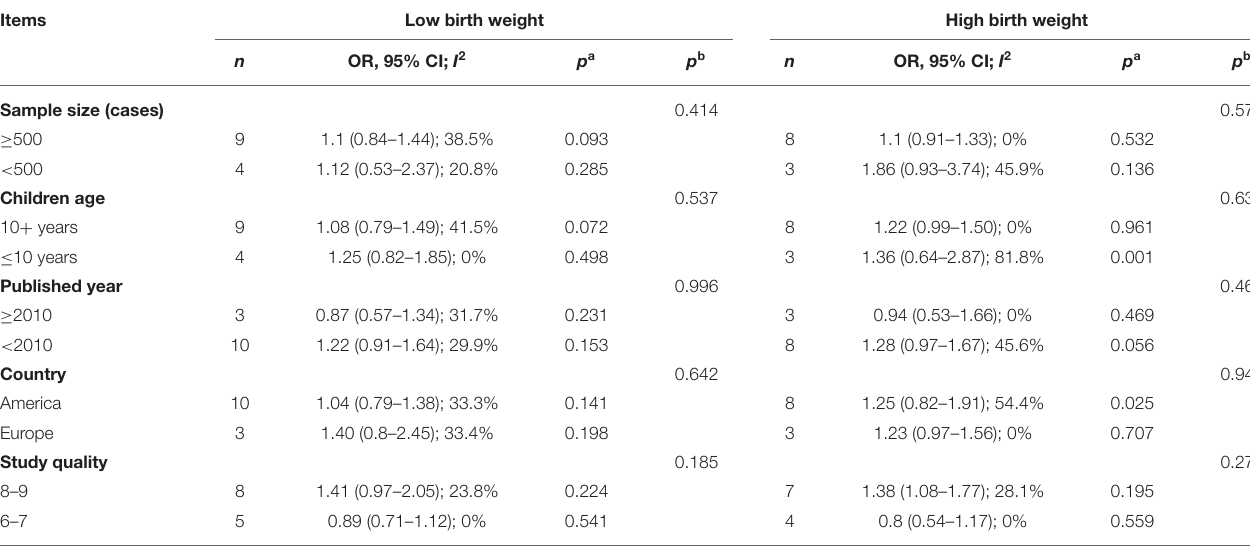
TABLE 2 | Subgroup analysis for birth weight and AML.